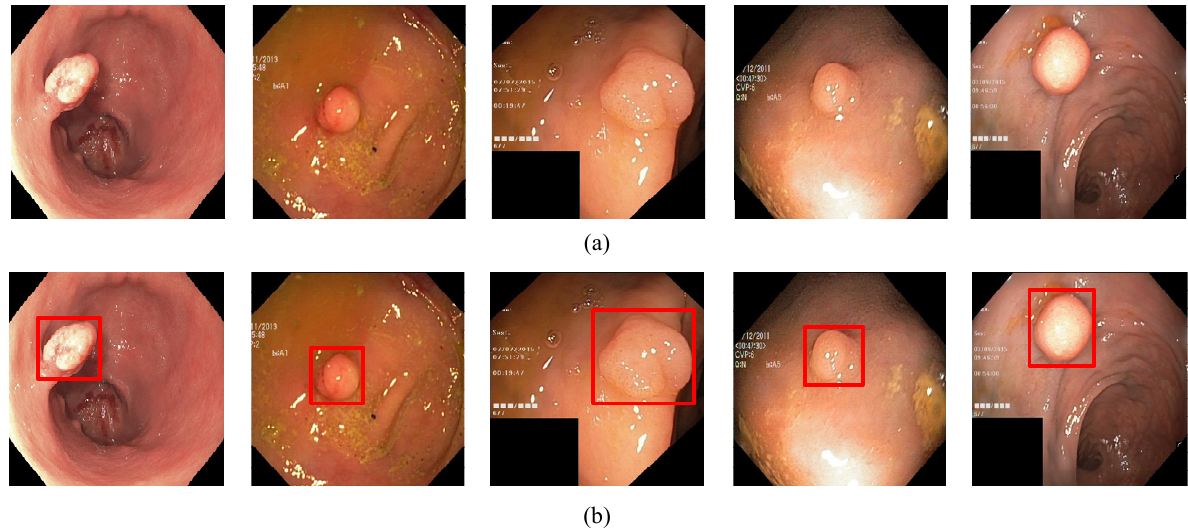
Figure 1. The polyp object detection Kvasir-SEG dataset: ( a ) Polyp image samples, ( b ) ground-truths with bounding boxes.The red squares in the figure are the bounding boxes of the polyps.